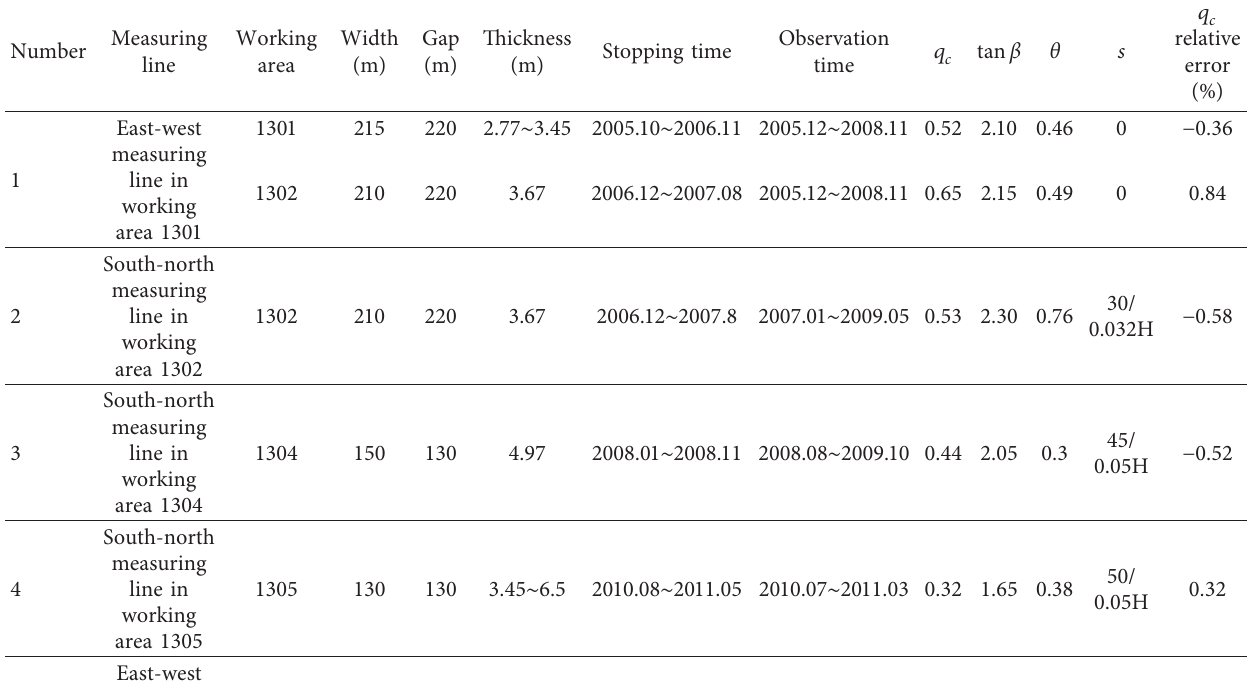
Table 2: Parameters for surface movement induced by fully caving coal mining. Measuring Number